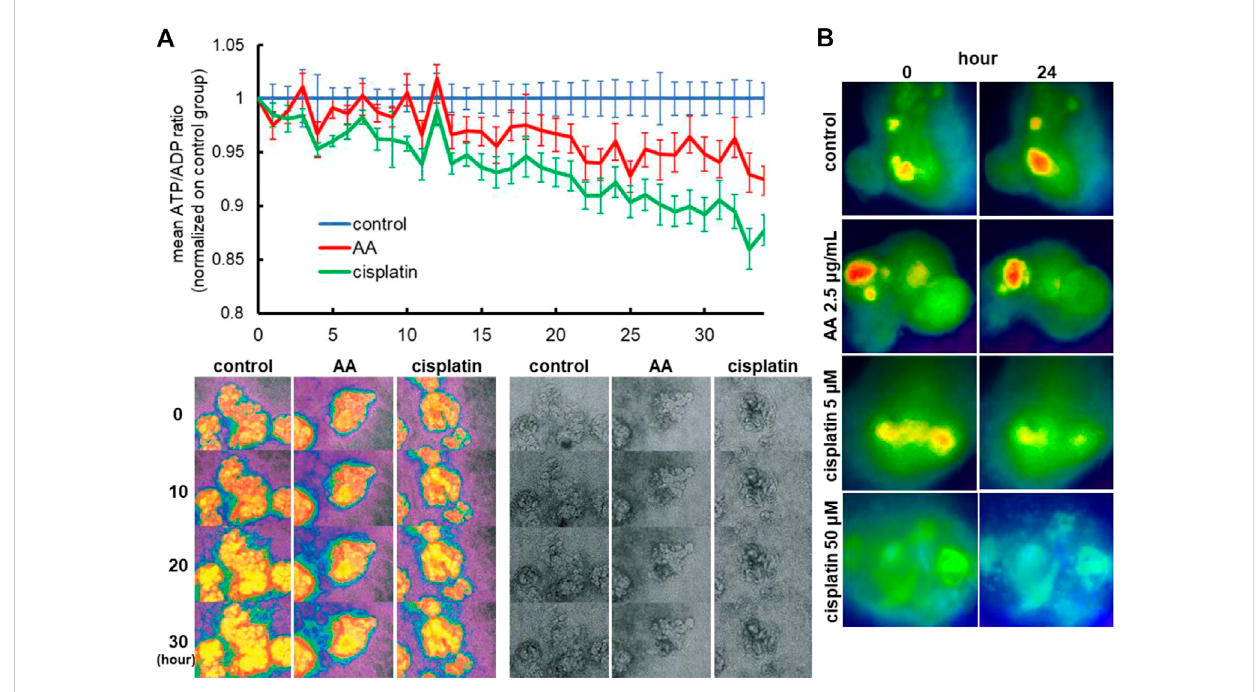
FIGURE 7 Reporter organoids with real-time biosensor Perceval HR to detect ATP/ADP ratio. (A) Detection of nephrotoxicity by live monitoring of ATP/ADP ratio in 2D reporter organoids treated with 2.5 μ g/mL AA and 5 µM cisplatin. (B) Representative images of ATP/ADP ratio monitoring in minimized 3D reporter organoids cultured on 384-well plates. The organoids were exposed to various toxicants (2.5 μ g/mL AA, 5 or 50 µM